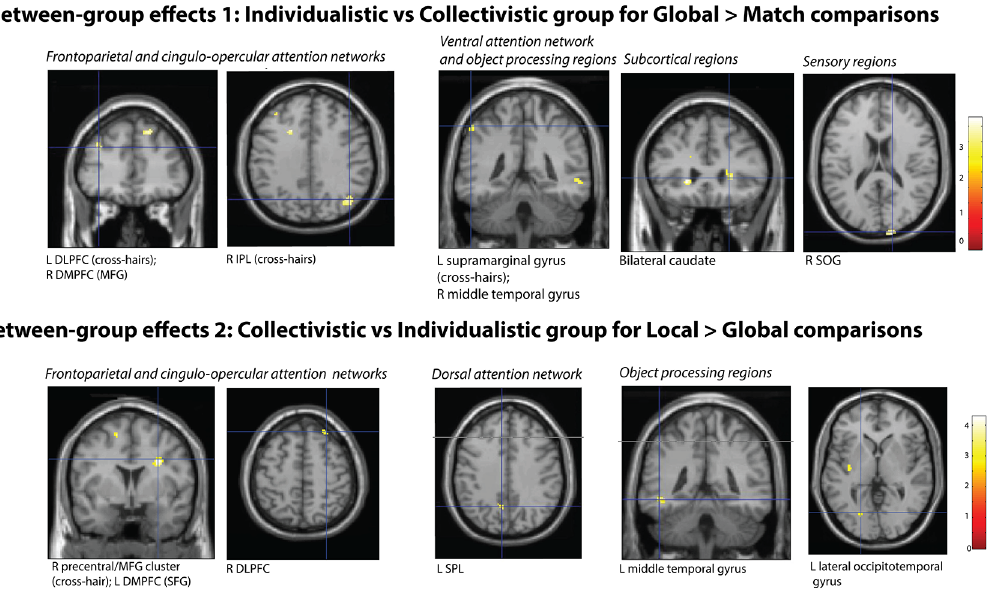
Fig 3. Between group SPM activation maps. 1. Individualistic (IND) > Collectivistic (COL) between group-comparisons for global vs match comparisons; see Table 3 for coordinates and significance levels; 2. Collectivistic (COL) > Individualistic (IND) between- group comparisons for local vs global comparisons; see Table 4 for coordinates and significance